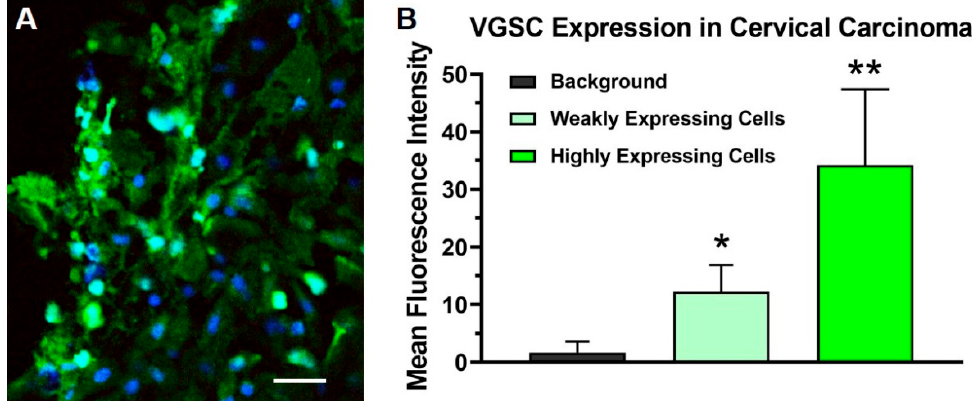
Figure 1. The photomicrographs depict the immunohistochemical labeling of voltage-gated sodium channels (VGSCs) (green) in a biopsy of the stage IIB carcinoma of the cervix obtained from the patient prior to treatment with targeted osmotic lysis (TOL). Sections were incubated and then processed with a goat-anti-rabbit 488 Alexa fluorophore secondary antibody, 1:800 dilution. Nuclei were counterstained with DRAQ5 (blue; dilution 1:600). Twelve images taken with a Leica DMi8 confocal microscope at 40× oil magnification were reviewed for evidence of VGSC labeling. Panel ( A ) depicts a representative portion of the biopsy where many cells, approximately 40% of the total, highly expressed VGSCs. Cellular profiles from three sections were outlined and the mean fluorescence intensity was measured using the ImageJ-FIJI software (imagej.nih.gov; accessed on 19 May 2021) to quantify the sodium channel expression. The histogram ( B ) presents the average mean fluorescence intensity measured from 50 intensely stained and 50 weakly stained cell profiles compared to the background indicative of the level of VGSC expression in highly expressing tumor cells and minimally expressing neoplastic and stromal cells, respectively. A one-way ANOVA was significant ( p < 0.00001); * = p < 0.001 compared to the background; ** = p < 0.001 compared to weakly expressing cells (Student’s t -test with Scheffe’s adjustment). Calibration bar in A = 25 µm.